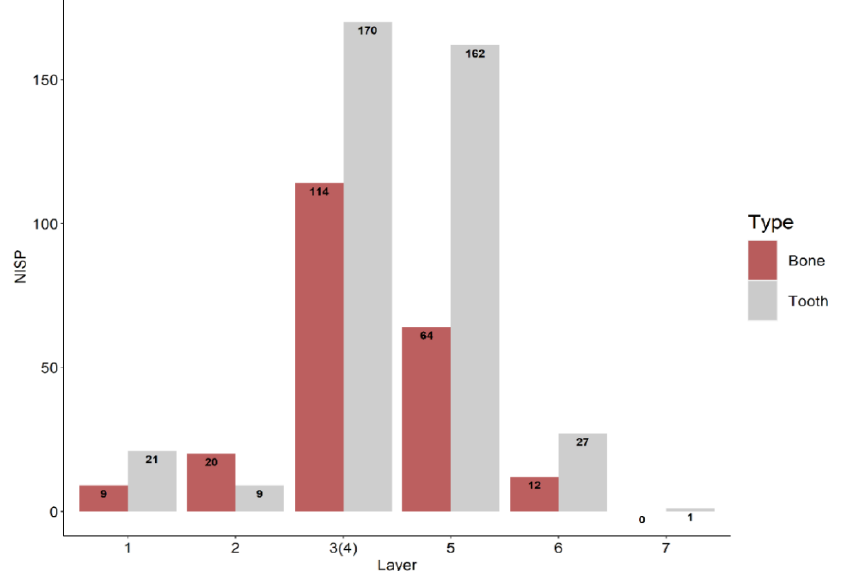
Figure 9. Relationship between identified bone and tooth for Artiodactyla, Perissodactyla, Testudinata, Primates, and Cyprinidae within Area 3 at Ban Rai Rockshelter, listed as the number of identified specimens (NISP). Table 2. Summary of identified taxa in the Ban Rai Rockshelter zooarchaeological assemblage. Area 1 includes Layers 2 – 4 of both S1E4 and S2E12. Area 2 includes only Layer 4 of pit S1E6, S2E14, and